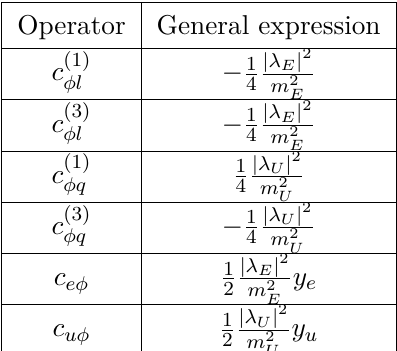
Table 13. Matching for the ψH terms in the EU model. Since all coefficients depend on only one mass, the equal mass limit m